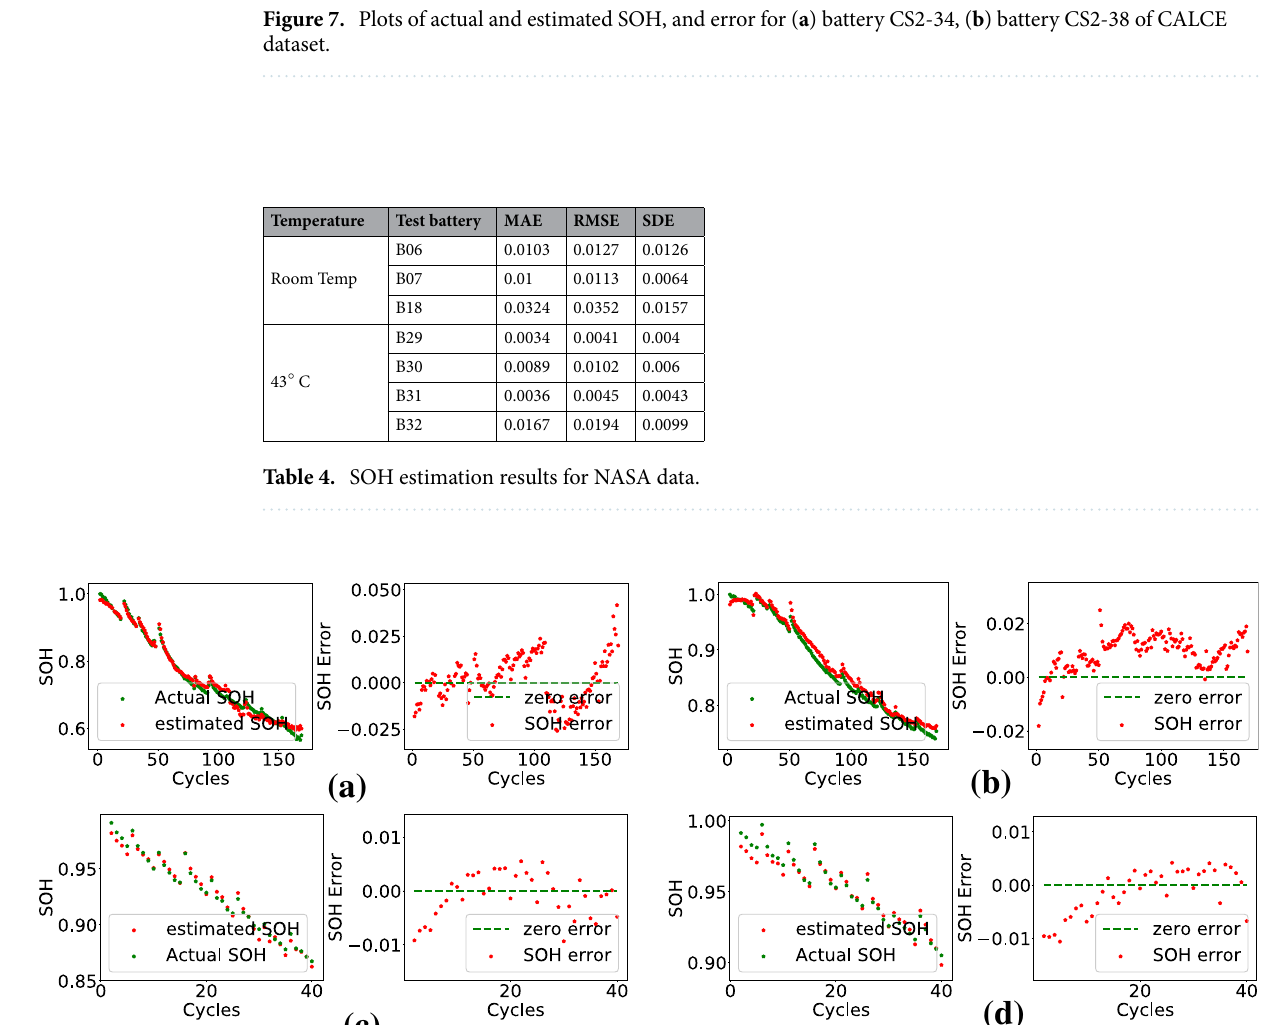
Battery data collected at two different temperatures were used in the experiment. Data of B05, B06, B07, and B18 were collected at room temperature. B29, B30, B31, and B32 data were collected at an elevated temperature of 43 ◦ C. The last FC layer of the base ANN was fine-tuned on B05 data. Other cell data were used for blind